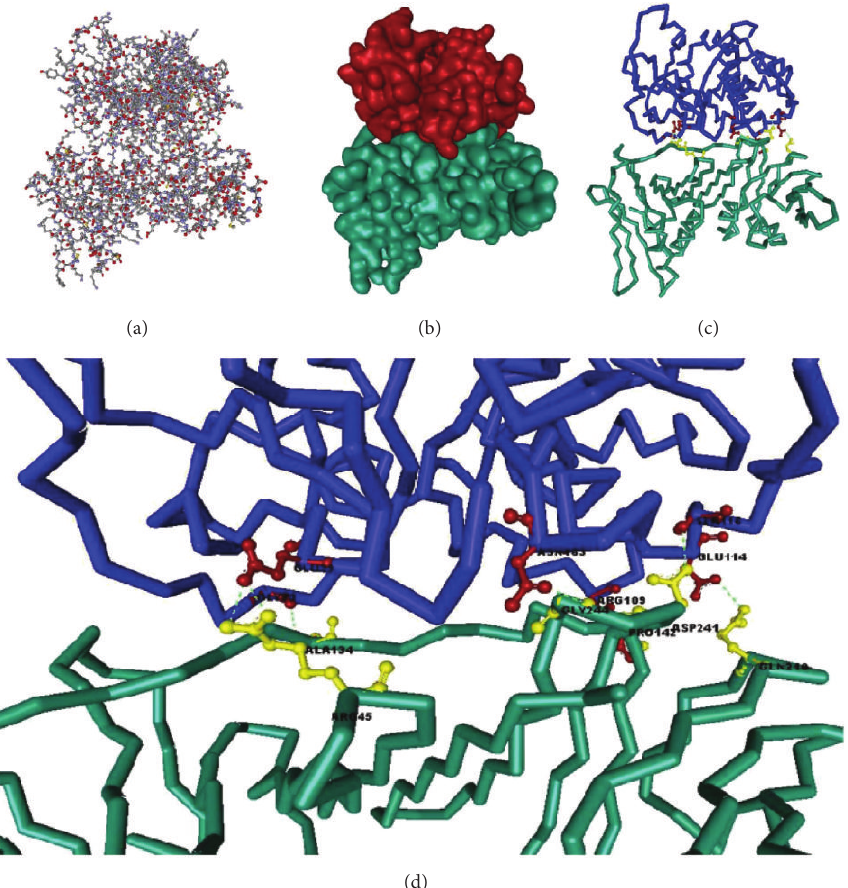
Figure 3: BCL-2 and RAD9 interaction represented in ball and stick (a), surface (b), sticks (c), and interacting amino acids of both proteins (d).